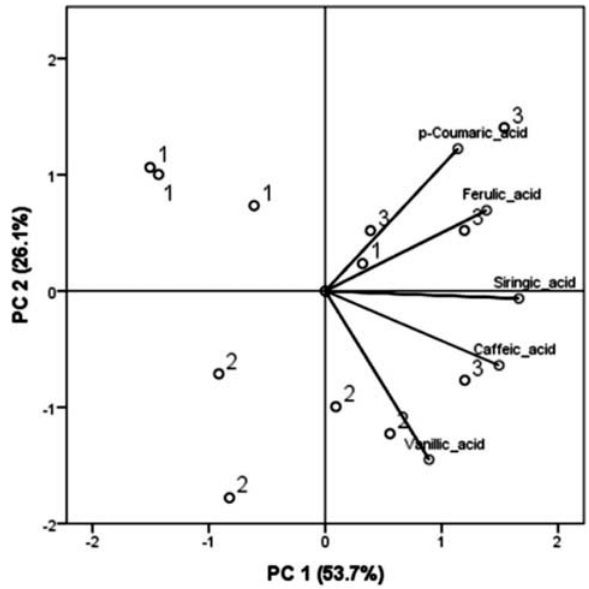
Figure 3. PCA biplot displaying the position of wine samples and descriptors in the plane PC 2 vs. PC 1 for twelve Slovenian red wi- nes. The objects were lebelled by the wine